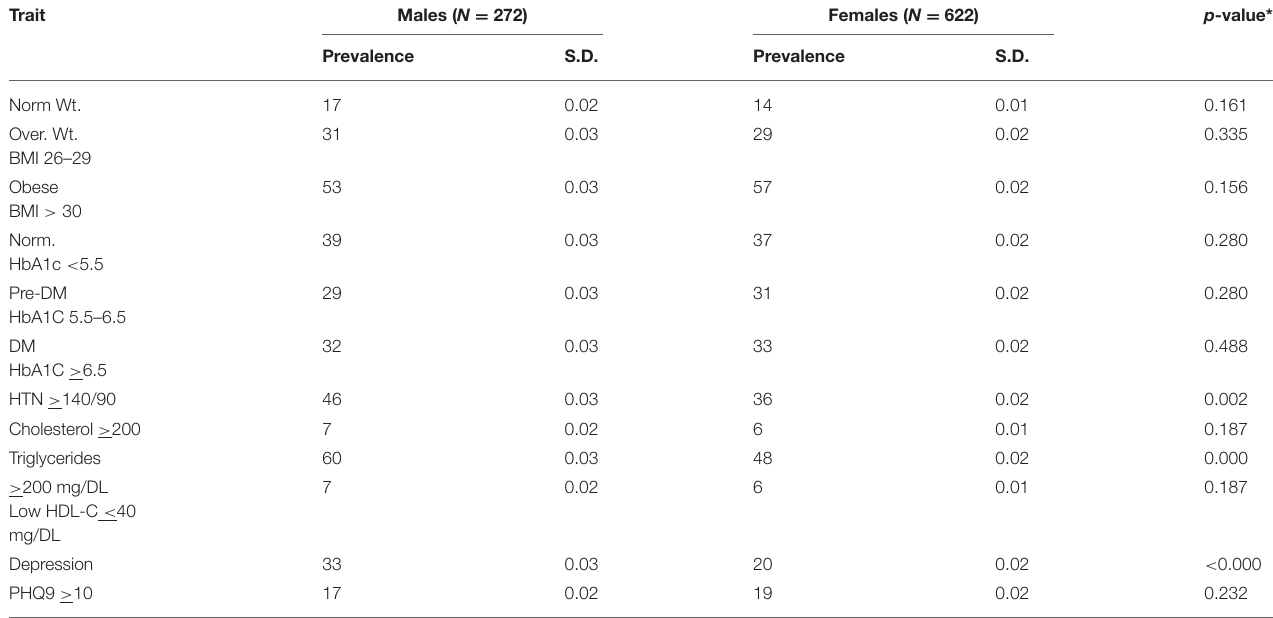
TABLE 1 | Total and sex-specific prevalence statistics for clinical outcomes. Trait Males ( N = 272) Females ( N = 622) p -value* Prevalence S.D. Prevalence S.D. Norm Wt.